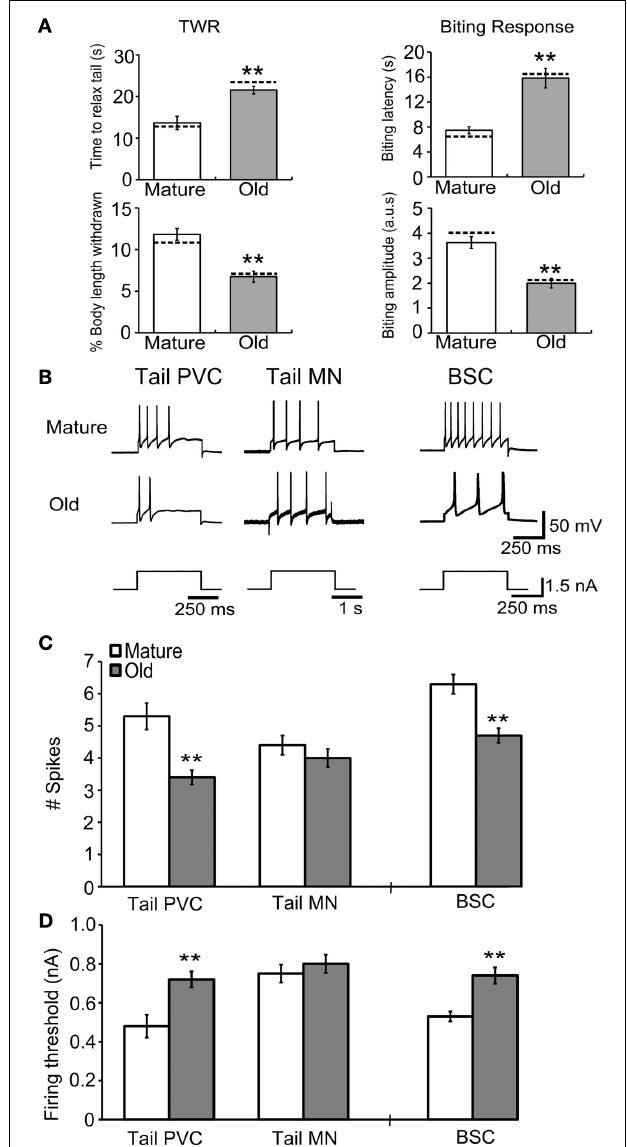
FIGURE 6 | Behavioral declines during aging correspond to changes in response to current injection in tail and buccal sensory neurons. (A) The time to relax tail following tail touch increased and percent of body length withdrawn decreased significantly with age in cohort 3 ( p ≤ 0 . 01 in each case, 2-sample t -tests). The biting latency increased and biting amplitude decreased significantly with age ( p ≤ 0 . 01 in each case; n = 8 for M, n = 9 for O). Dotted horizontal lines are individual behavioral measurements in animals used for electrophysiology in (B) . (B) Representative responses during 1.5nA current injection for 500ms in tail PVC and BSC sensory neurons and 2s in tail motoneurons. (C) The number of APs fired during 1.5nA current injection decreased significantly with age in tail PVC and BSC sensory neurons ( p ≤ 0 . 01 in each case) while in tail motoneurons no change was observed. (D) Firing threshold increased significantly with age in PVC and BSC sensory neurons ( p ≤ 0 . 01 in each case) while in tail motoneurons no change was observed (Tail PVC: n = 26 for M, n = 24 for O; Tail MN: n = 19 for M, n = 18 for O; BSC: n = 16 for M, n = 23 for O). ∗∗ denotes significant difference from mature at p ≤ 0 .